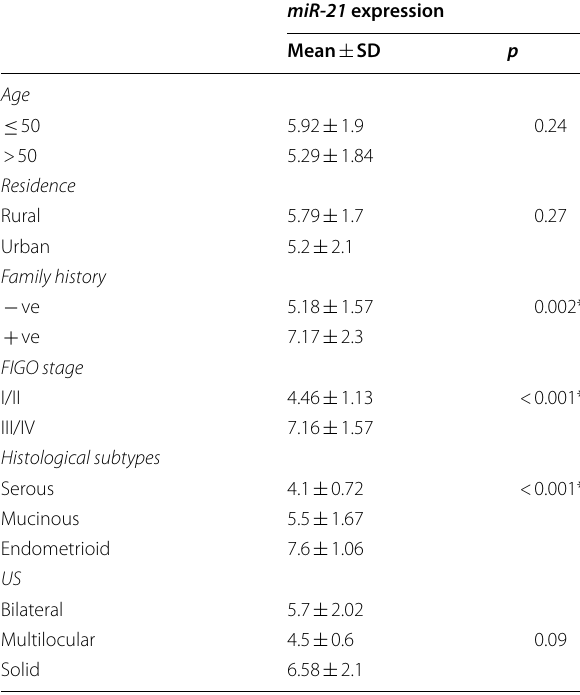
Table 4 Associations among serum miR-21 expression